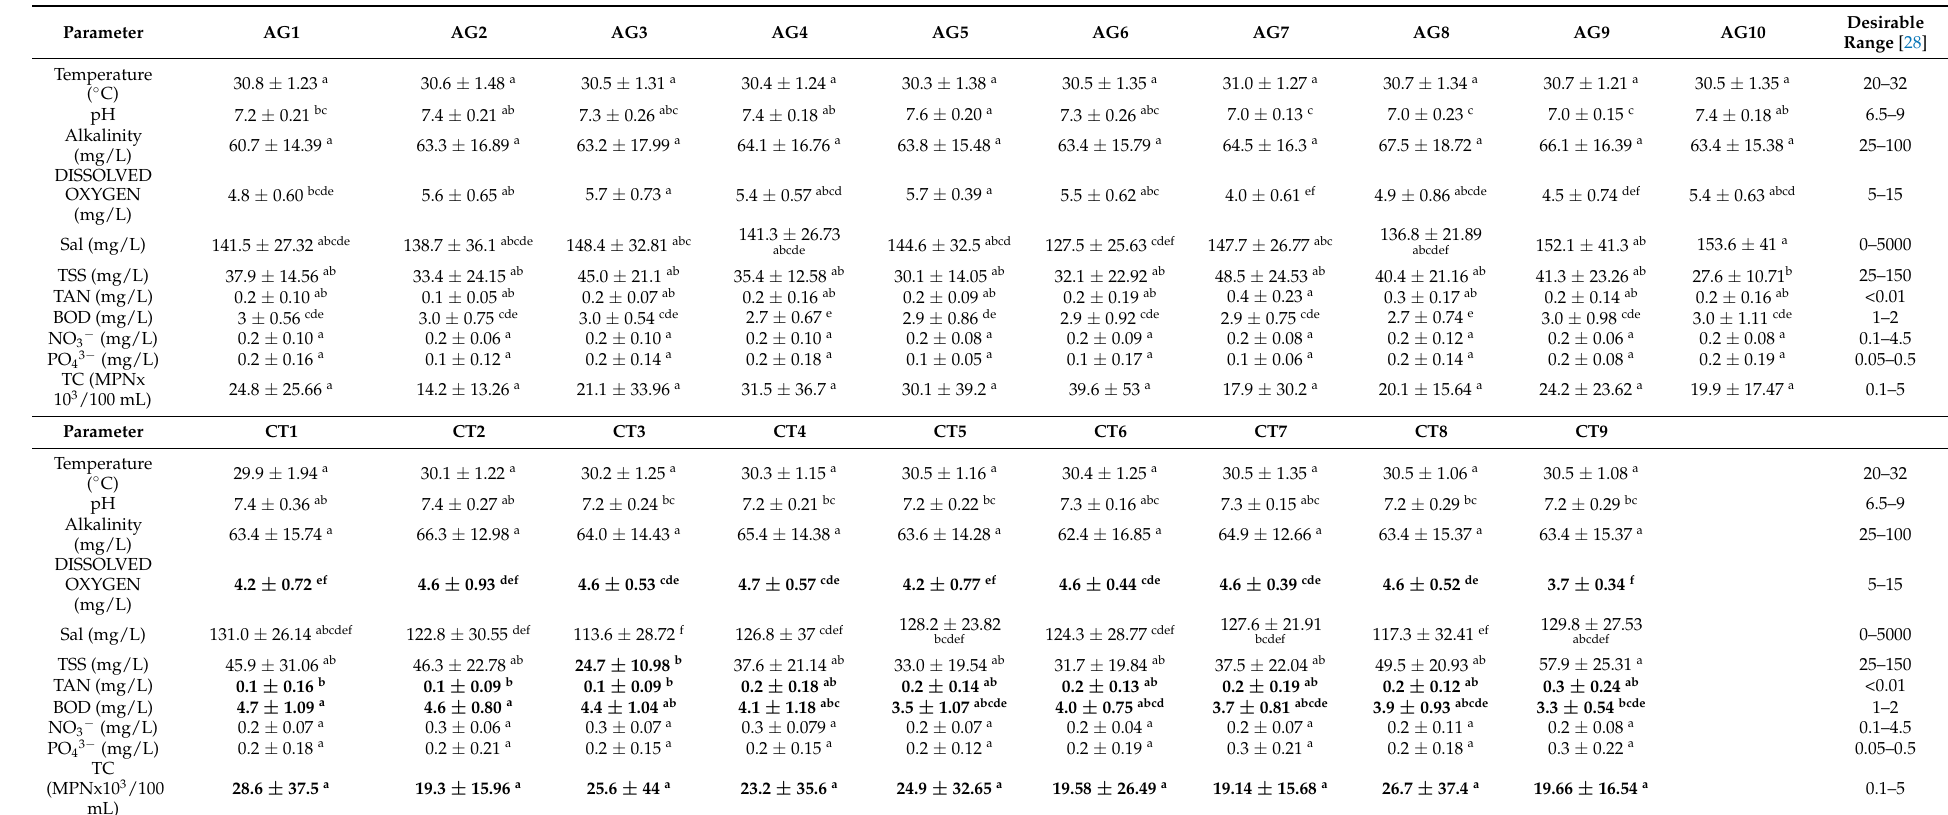
Table 2. Water quality of the Hau River in 2019 in An Giang (G1–AG10) and Can Tho Provinces